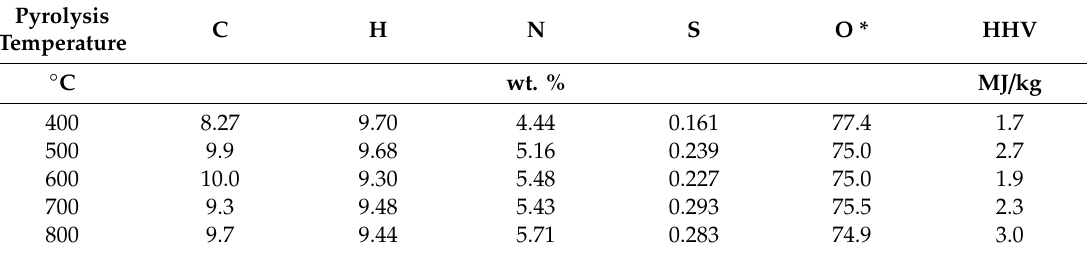
Table 5. Ultimate analysis and heating value of water condensate